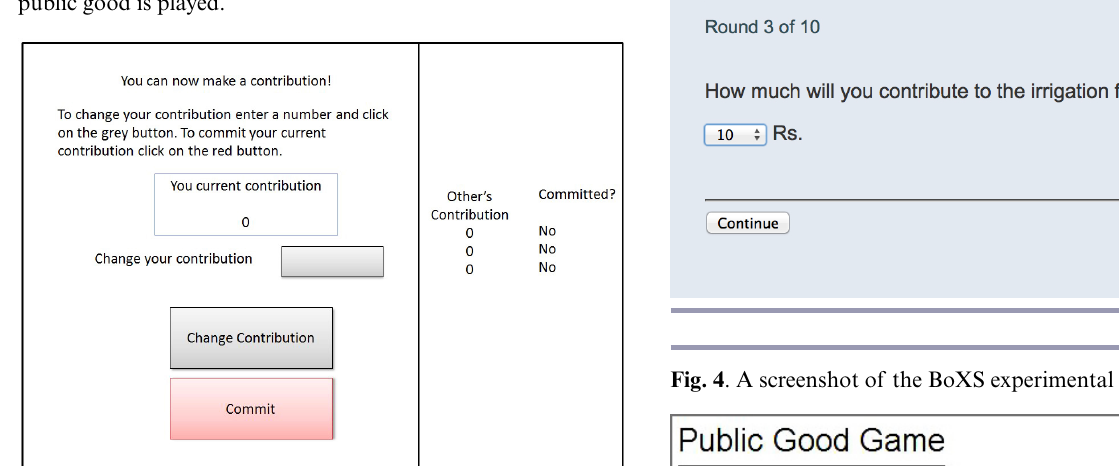
Fig. 2 . A screenshot of z-Tree experimental software when a public good is played.